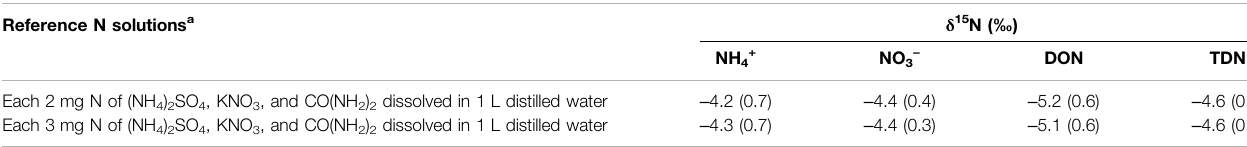
TABLE 2 | Results of the analyses of δ 15 N of reference N solution containing NH 4+ , NO 3 − , DON, and TDN using the proposed methods. Reference N solutions